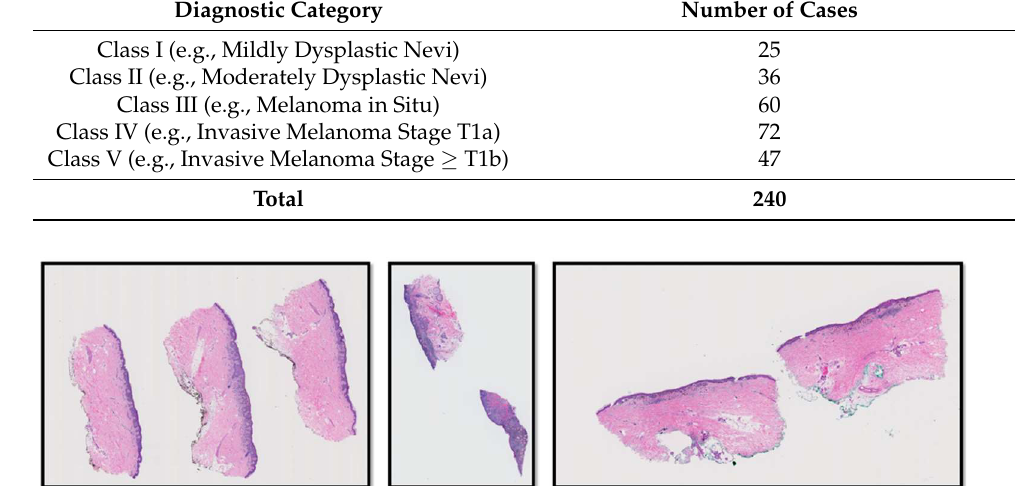
Table 1. Distribution of diagnostic categories in M-Path data. Diagnostic Category